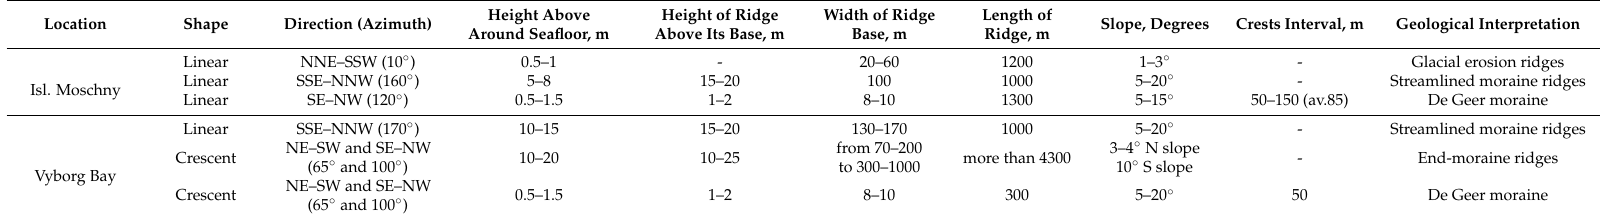
Table 1. Results of morphometric analyses of MBES and SBP